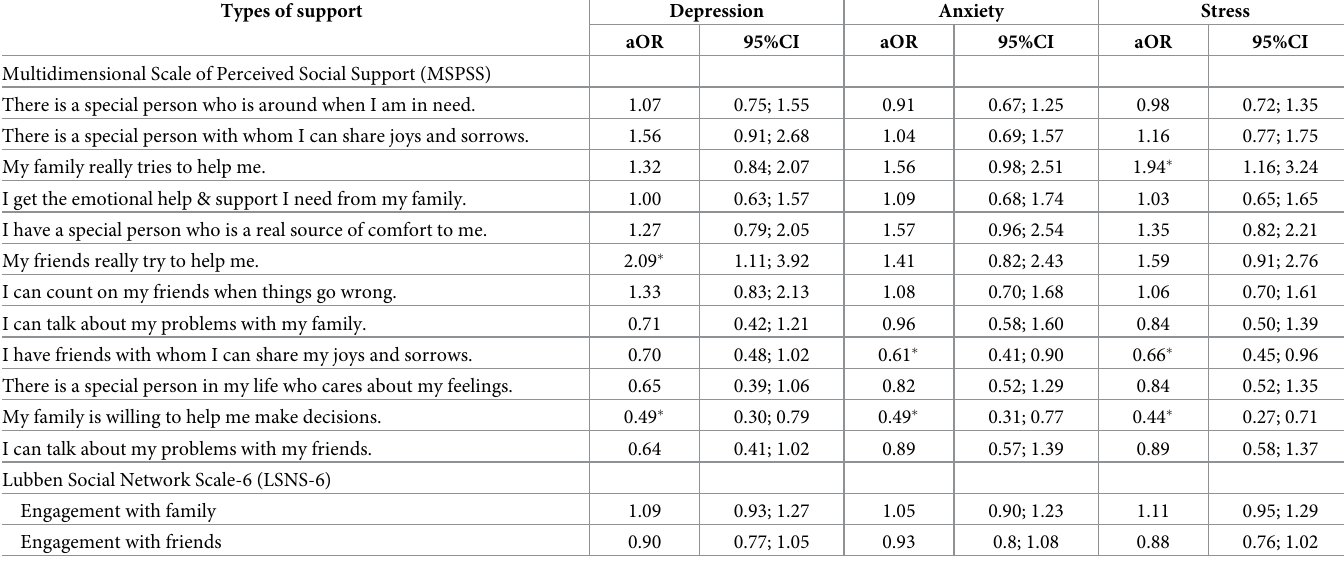
Table 4. Multi-level logistic regression for identifying associations between structural and functional social support with depression, anxiety, and stress among young